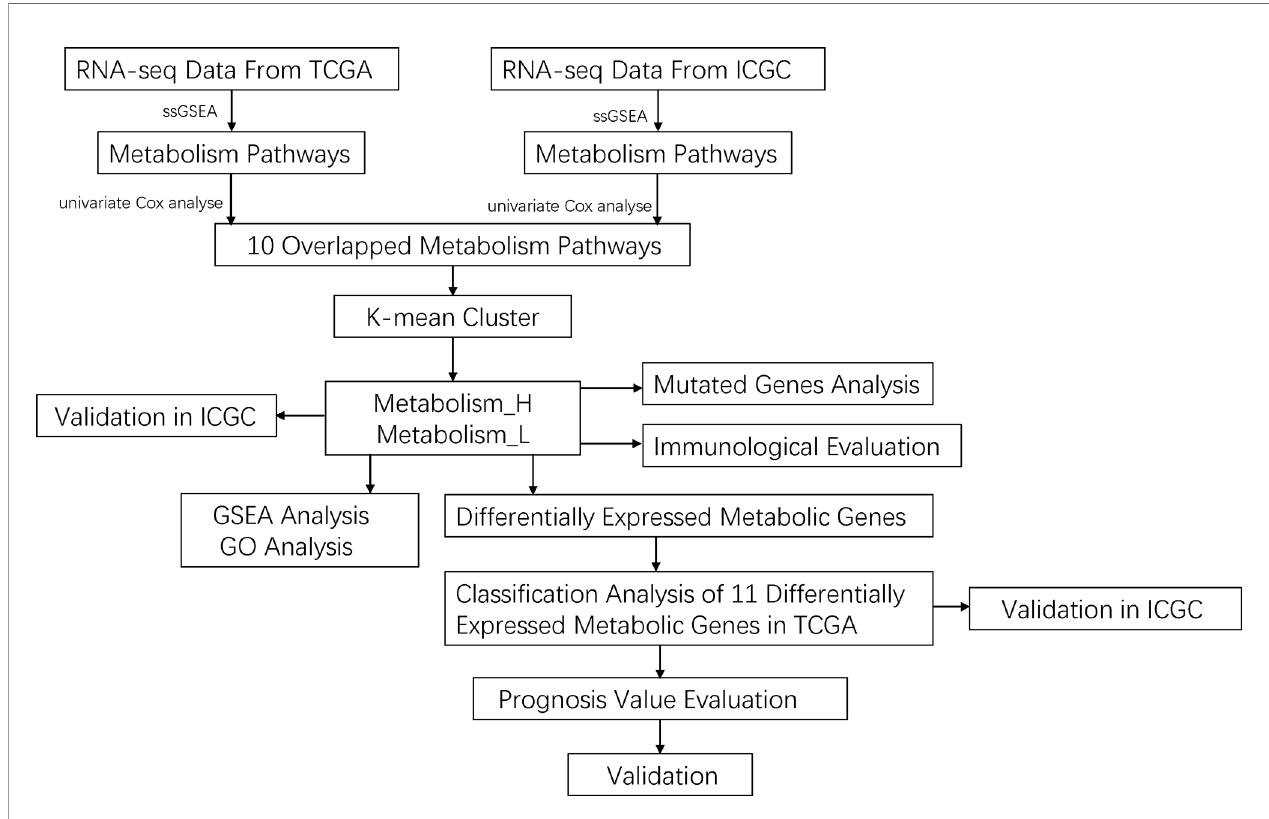
FIGURE 1 | The work fl ow of this